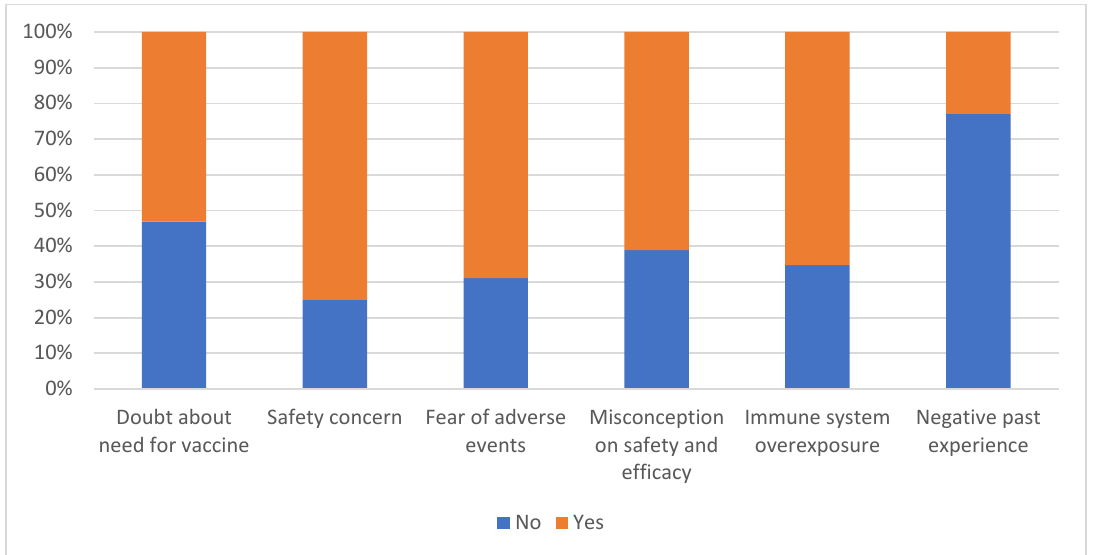
Figure 2. Multidimensional bar chart indicating reasons for vaccine refusal assessed by vaccine refusal/hesitancy items.